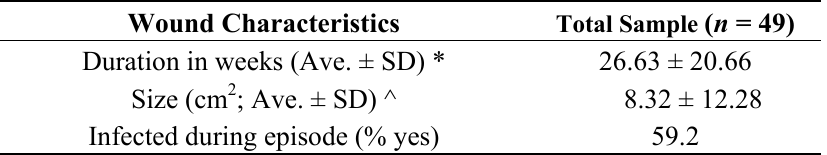
Table 3. Characteristics of study wound for study participants ( n = 49).